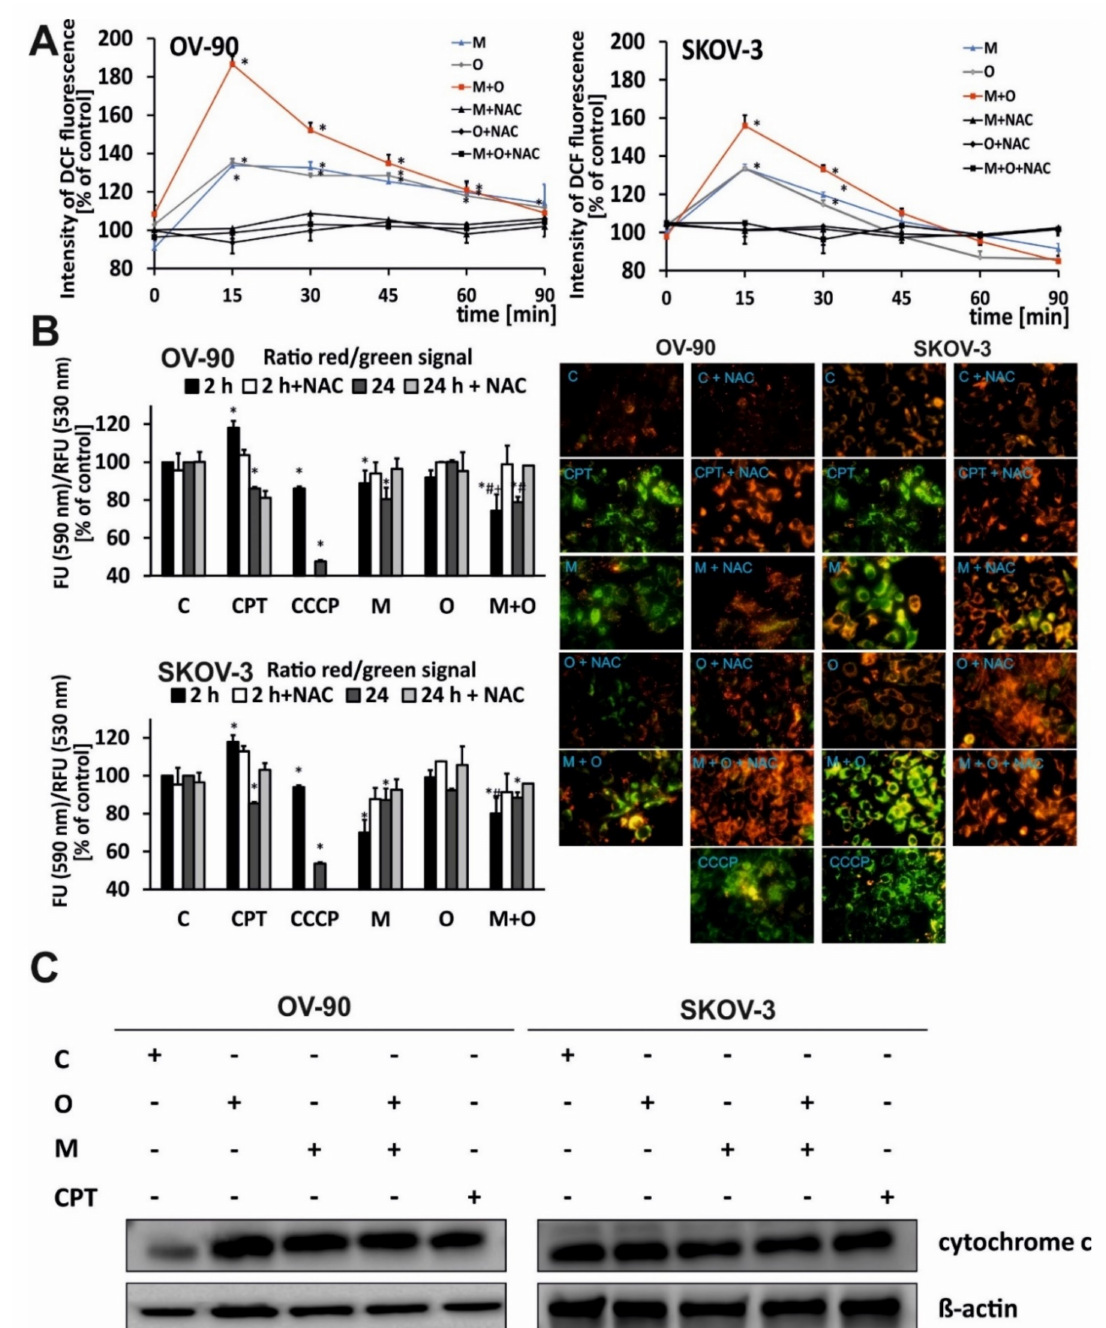
Figure 3. Metformin combined with olaparib induced oxidative stress and decreased the mitochondrial membrane potential. ( A ) The kinetics of ROS generation in OV-90 and SKOV-3 cells treated with O (20 µ M), M (20 mM), or O (20 µ M) + M (20 mM) were measured for up to 90 min in the presence or absence of an antioxidant (NAC); C: control, CPT: Camptothecin. ( B ) The fluorescence ratio of JC-1 dimers/JC-1 monomers in the control was assumed to be 100%. OV-90 and SKOV-3 cells were stained with the fluorescence probe JC-1 after 24 h of incubation with O (20 µ M), M (20 mM), or O (20 µ M) + M (20 mM) or carbonyl cyanide m-chlorophenyl hydrazone (CCCP) (10 µ M), or CPT (5 µ M). ( C ) Cytochrome c and β -actin expression was analyzed by western blotting. All data are from three biologic assays and are graphed as the mean ± SD. * p < 0.05 for olaparib, metformin, or a combination of both drugs vs. control cells; # p < 0.05 for olaparib vs. com-bination (O + M); + p < 0.05 for metformin vs. combination (O +